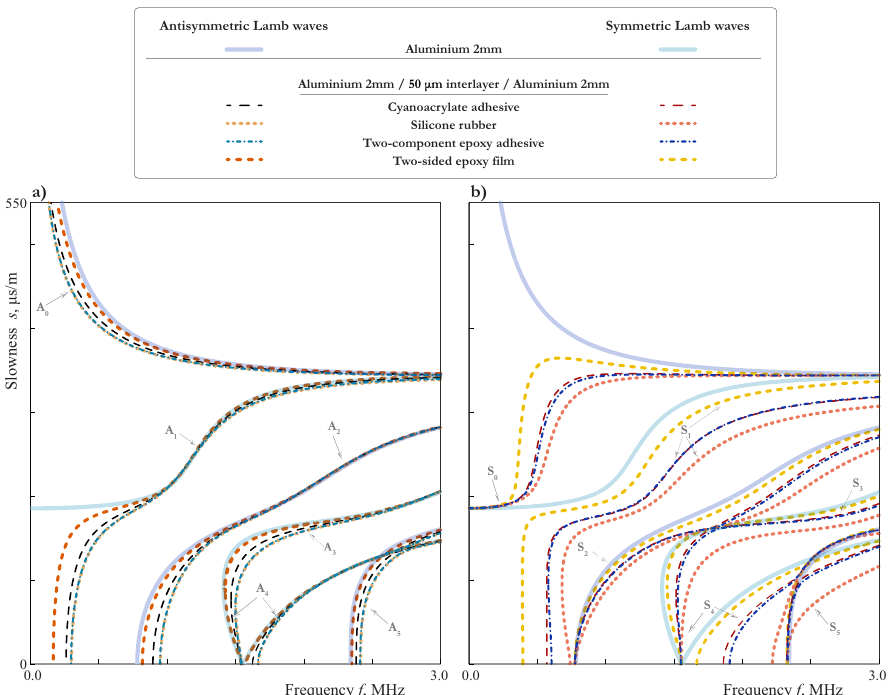
Figure 7. Slownesses of antisymmetric ( a ) and symmetric ( b ) LWs propagating in 4.05 mm thickness plate (2 mm aluminium/50 µ m interlayer/2 mm aluminium) for four materials: two-sided epoxy tape (dashed thick lines), two-component epoxy adhesive (dash-dotted lines), cyanoacrylate adhesive (dashed thin lines), silicone rubber (thick dotted